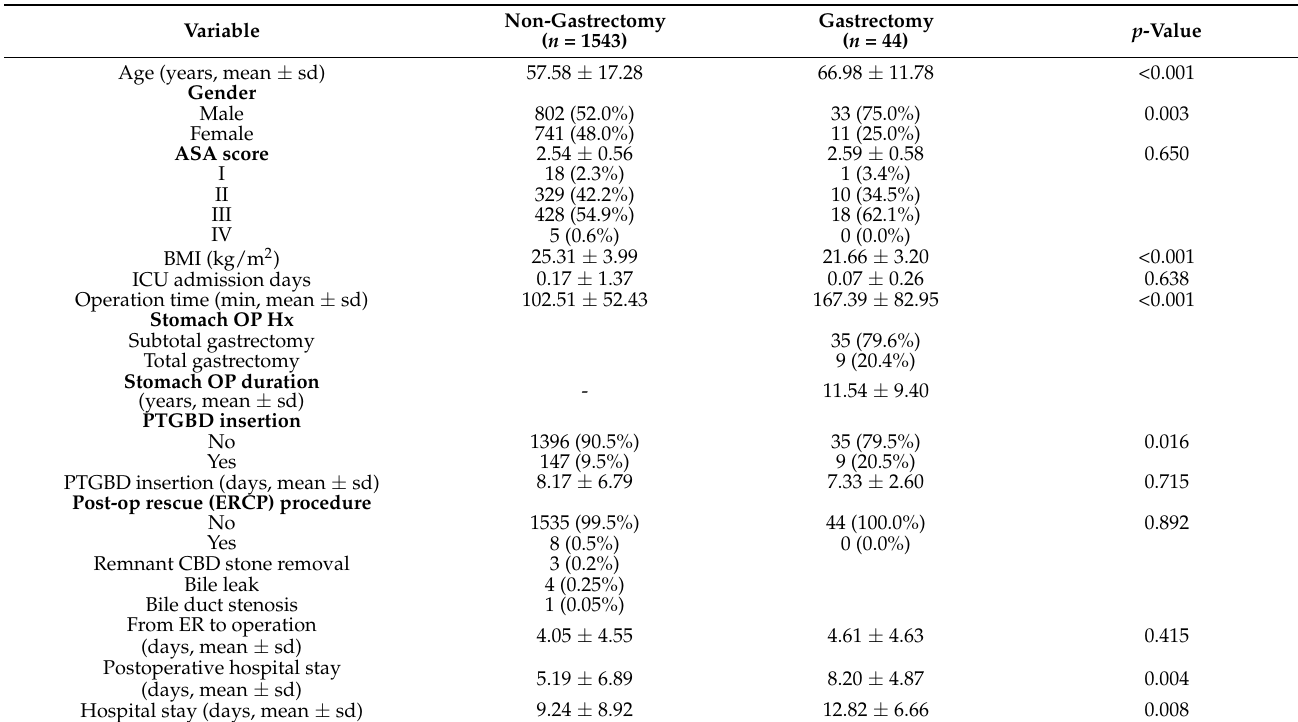
Table 1. Clinical characteristics of symptomatic cholecystitis